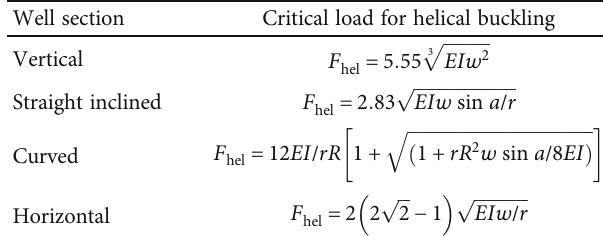
(cid:10) ffiffiffiffiffiffiffiffiffiffiffiffi EIw / r